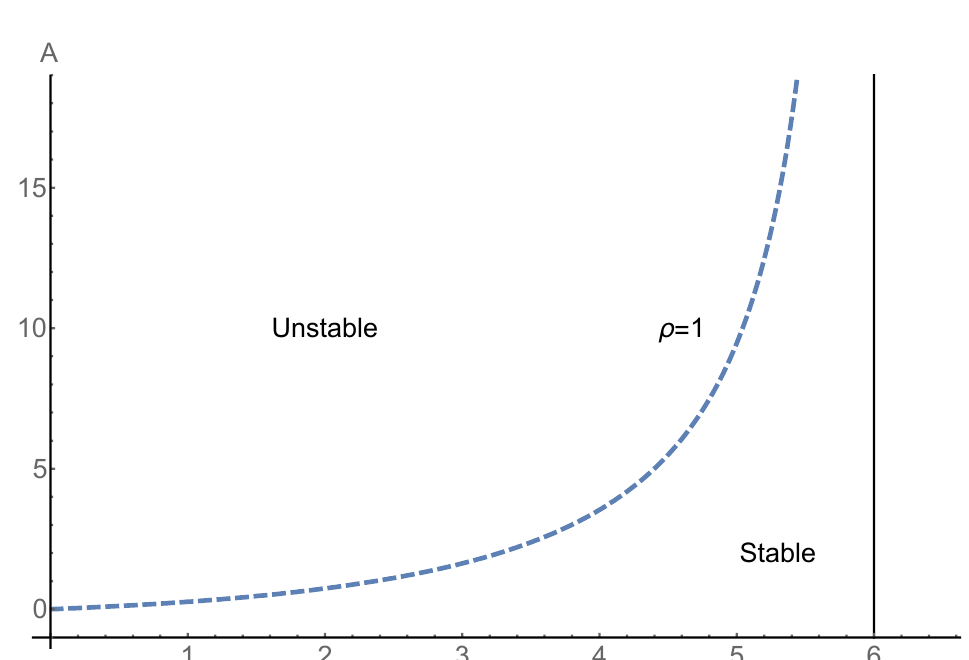
Figure 1 . We have shown the phase diagram in the f (cid:15); (cid:11) g -plane, setting (cid:26) = 1. The black vertical line corresponds to (cid:15) = (cid:15) max . Stable and unstable regions are also marked. Near (cid:15) ! (cid:15) max , A crit (cid:24) ( (cid:15) max (cid:0) (cid:15) ) (cid:0) 1 = 2